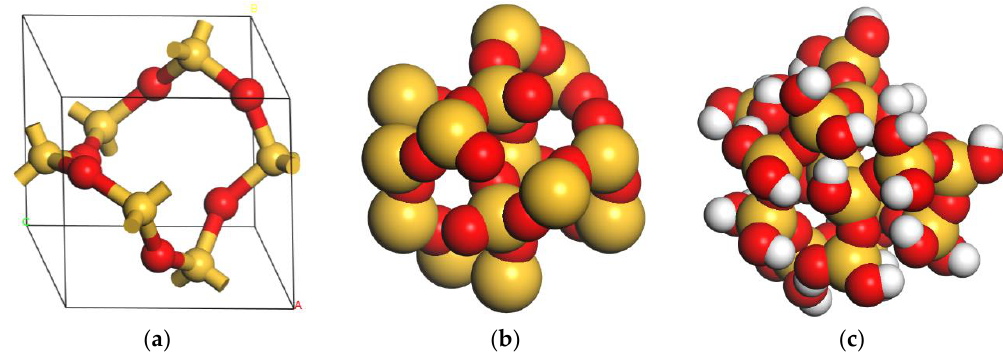
Figure 2. The SiO 2 models: ( a ) crystal structure of SiO 2 -quartz; ( b ) spherical SiO 2 nanoparticle with unsaturated bonds on the surface; ( c ) spherical SiO 2 nanoparticle of atomic termination on the surface.